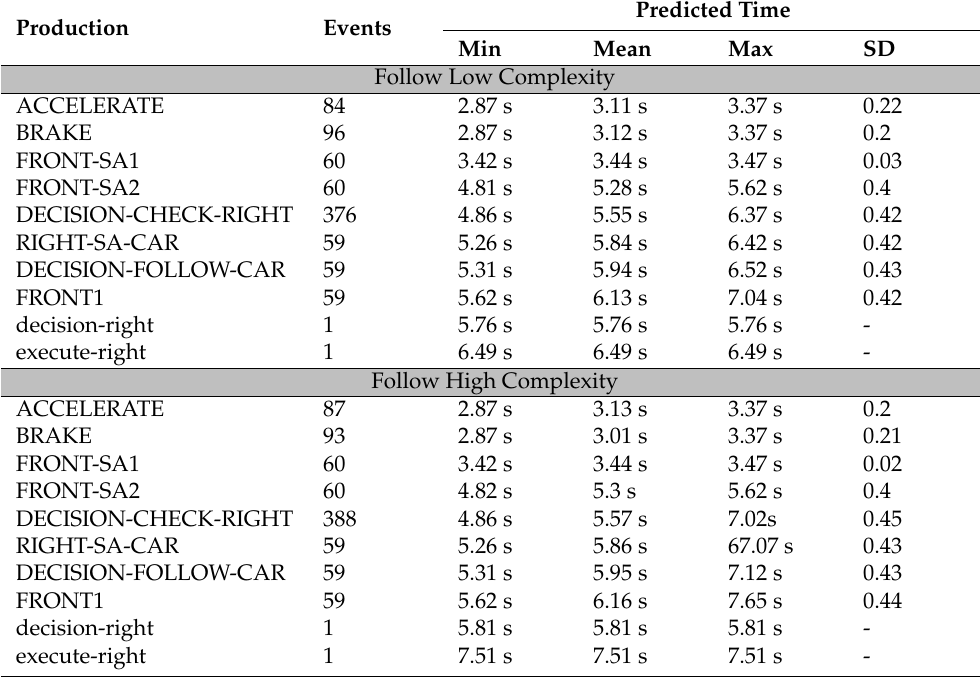
Table 2. Predicted time statistics of the cognitive model with a follow maneuver. Representation of minimum (Min), mean, and maximum (Max) values over N = 60 trials. Wrong decisions are in lower case letters (source: own